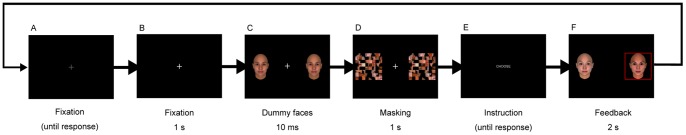
Sematic diagram of a typical trial during the blind choice task.Participants were required to press a key to initiate a trial (A), followed by a presentation of fixation for 1 s (B). Next, two identical dummy faces were presented for 10 ms (C) and followed by masking stimuli presented for 1 s (D). After the dummy faces were presented, participants were asked to respond in accordance with an instruction (e.g., “CHOOSE” represents to choose a preferred face). Once completed the response, target faces were presented (F). Note that participants were instructed that target faces were presented two times within a trial, one in C and another in F.